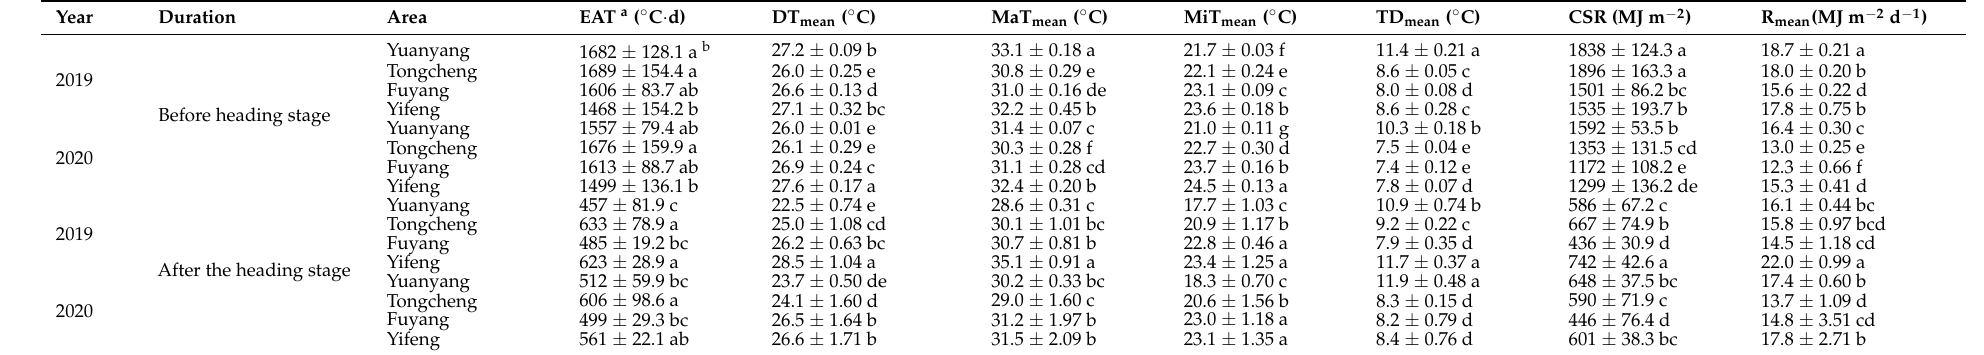
Table 1. Temperature and solar radiation condition before heading stage and after heading stage among different areas in 2019 and 2020.